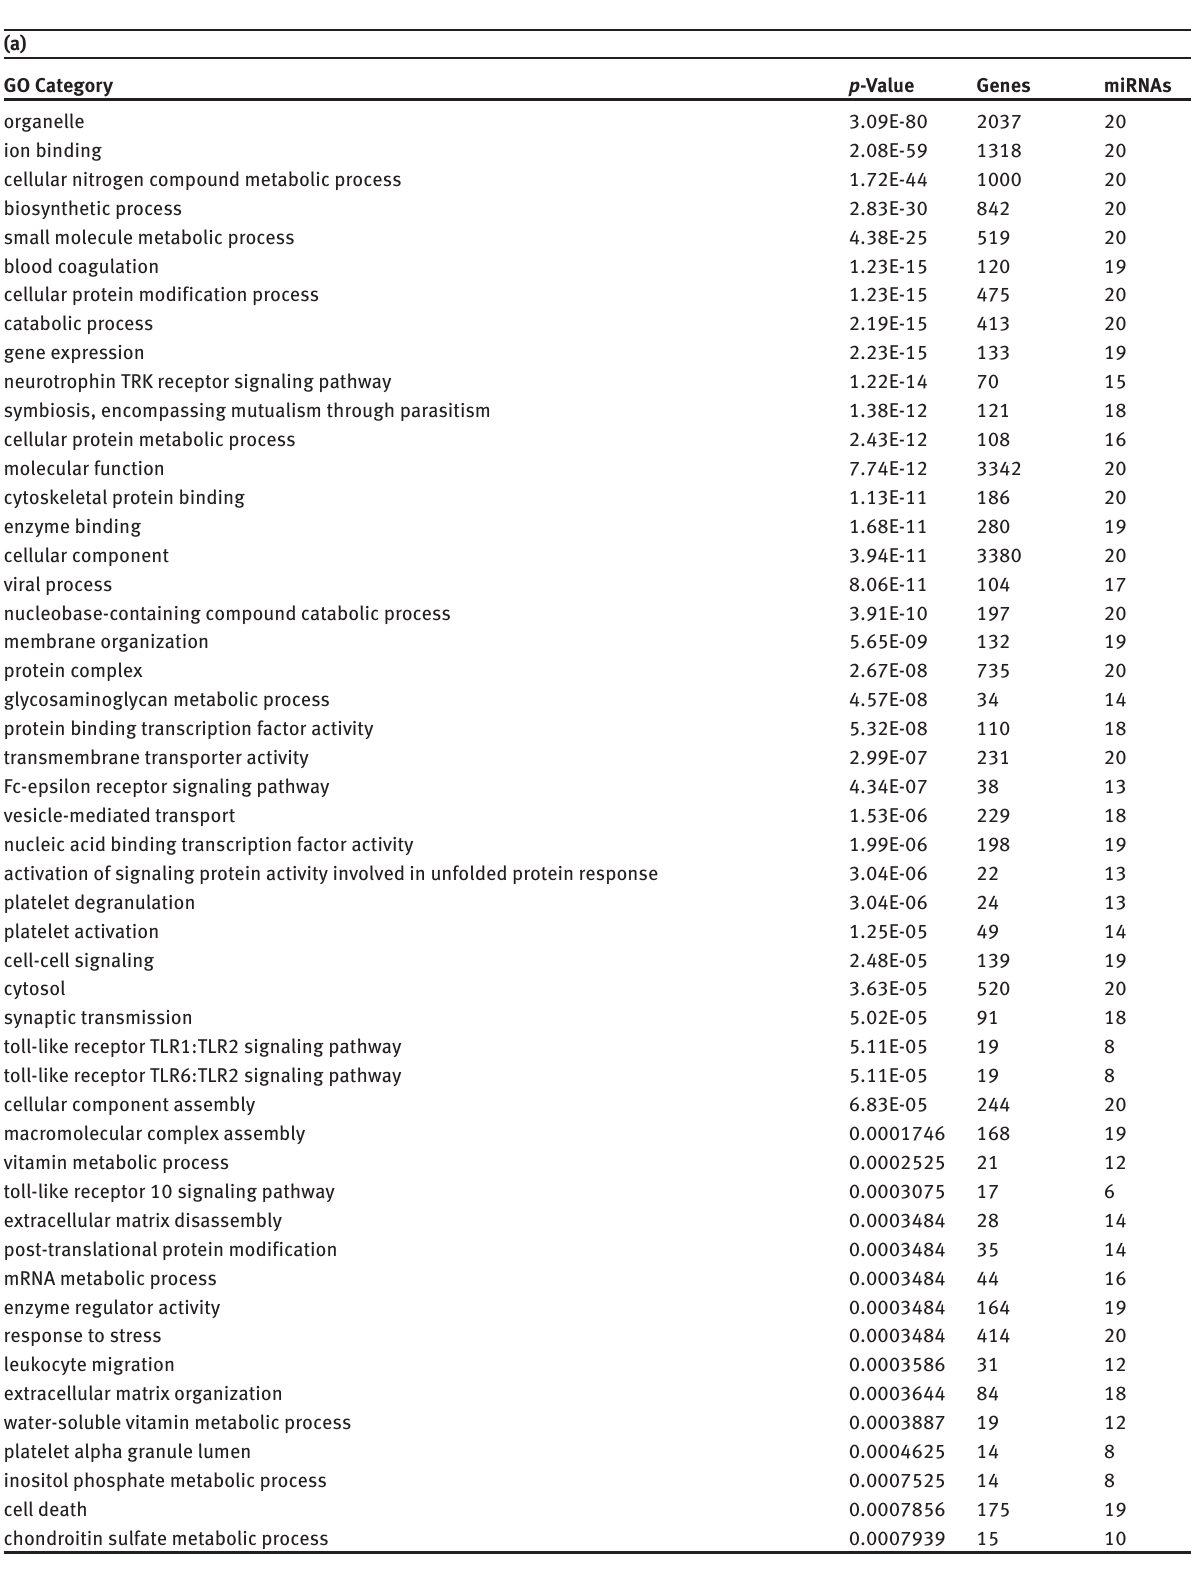
Table 4: GO analysis of biological processes (top 50) potentially affected by downregulated miRNAs (a) and upregulated miRNAs (b) due to SDF-1 treatment in human